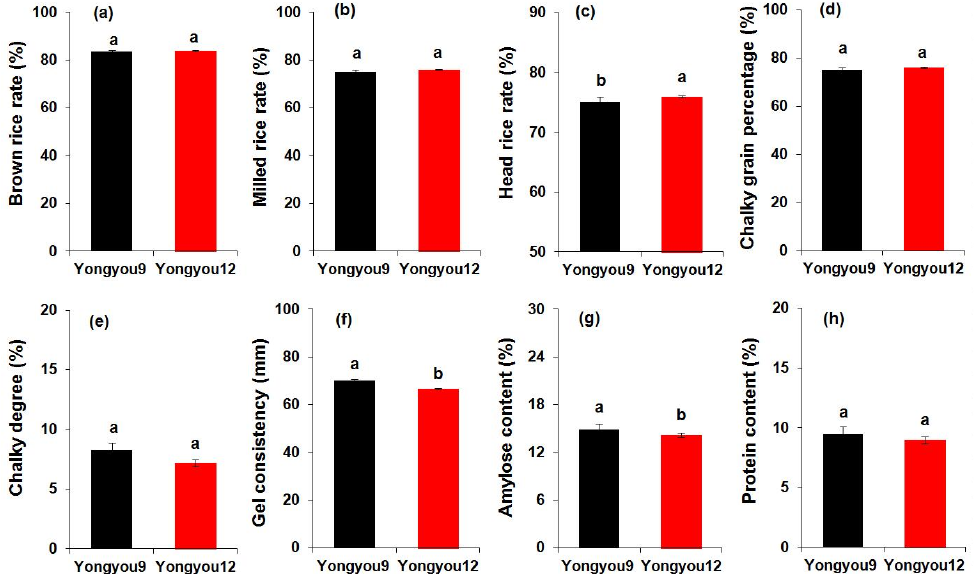
Figure 3. Grain quality of Yongyou9 and Yongyou12: ( a ) brown rice rate; ( b ) milled rice rate; ( c ) head rice rate; ( d ) chalky grain percentage; ( e ) chalky degree; ( f ) gel consistency; ( g ) amylose content; ( h ) protein content. Error bars denote ± standard deviation ( n = 3). Different letters indicate a significant difference at the 0.05 probability level.